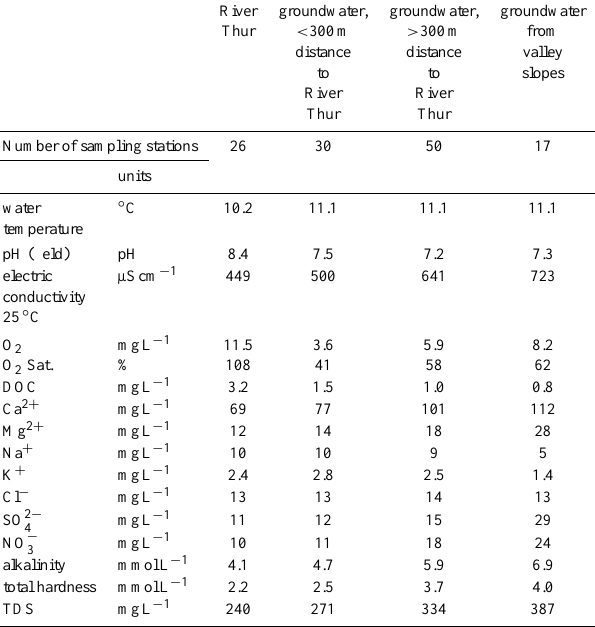
bank filtration. Yellow to red hues in Fig. 3 (low oxygen concentrations) represent bank filtration through a saturated zone in the lower part of the flood plain (direct bank filtra- tion). River Thur has a high organic load from WWTP outlets (see river water concentrations in DOC, in Table 1).